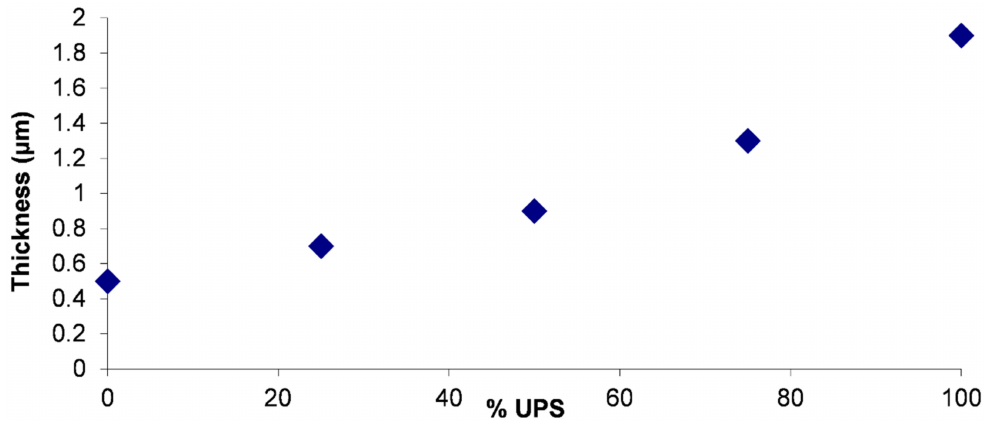
Figure 9. Evolution of the coating thickness according to the quantity of